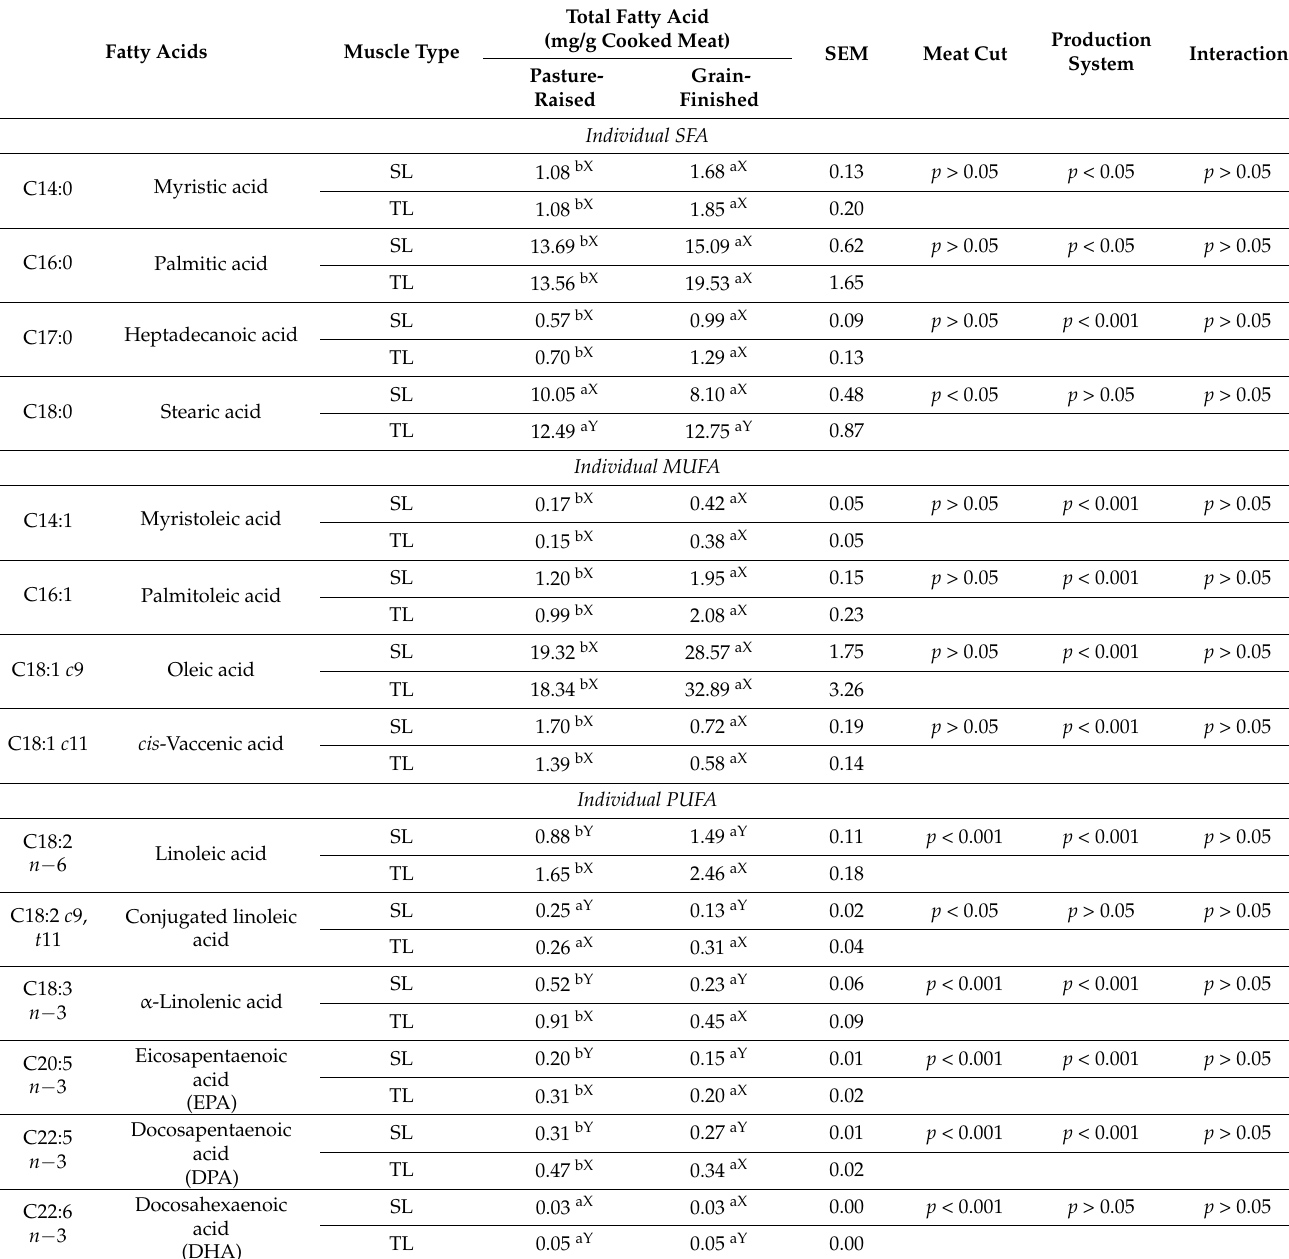
Table 3) among tenderloin and striploin, except for stearic acid. Table 3. Total fatty acid (TFA, selected) contents for cooked striploin (SL) and tenderloin (TL) from grain-finished and pasture-raised